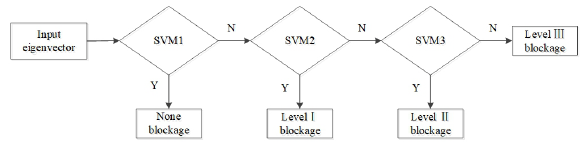
Fig. 9. Schematic diagram of SVM multi-classification method